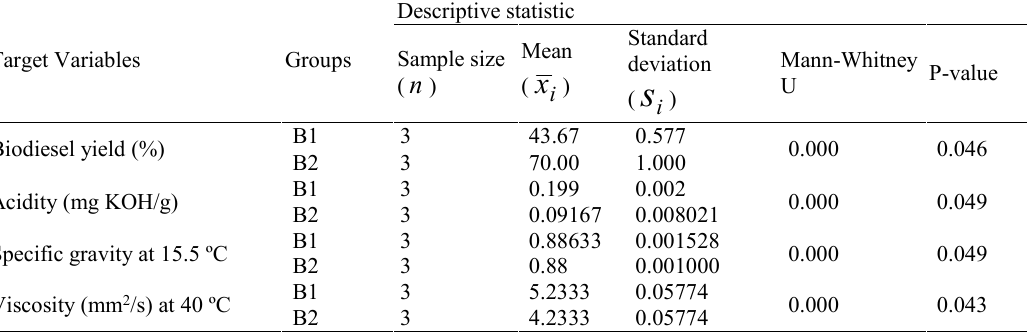
Table 4. Descriptive statistic of adsorption process on biodiesel quality. (B1: Biodiesel from waste oil; B2: biodiesel from treated waste